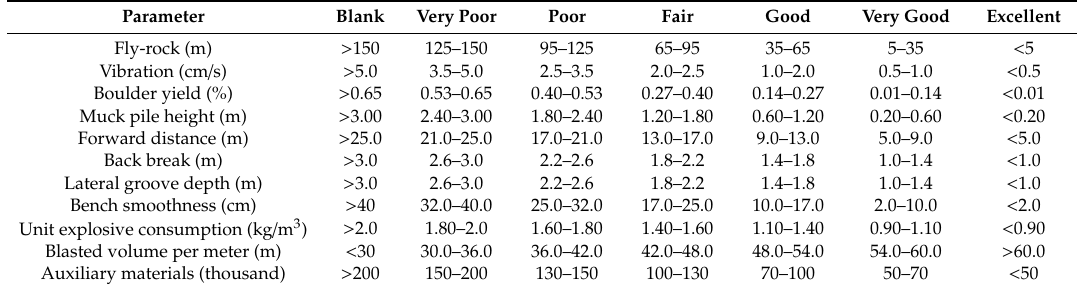
Table 5. The data ranges of parameters corresponding to membership degrees.